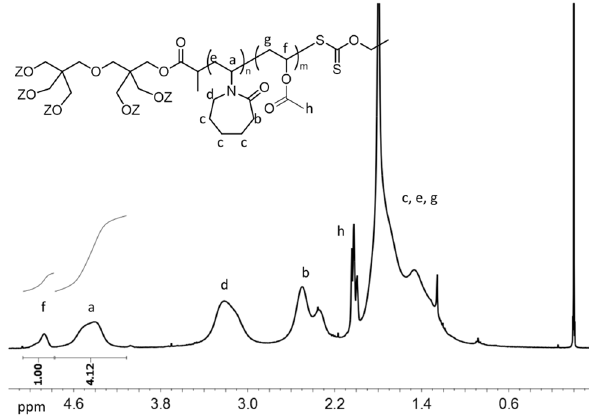
Figure 5. 1 H-NMR (400 MHz) spectrum of a star (PNVCL- b -PVAc) 6 copolymer in CDCl 3 (Table 2,